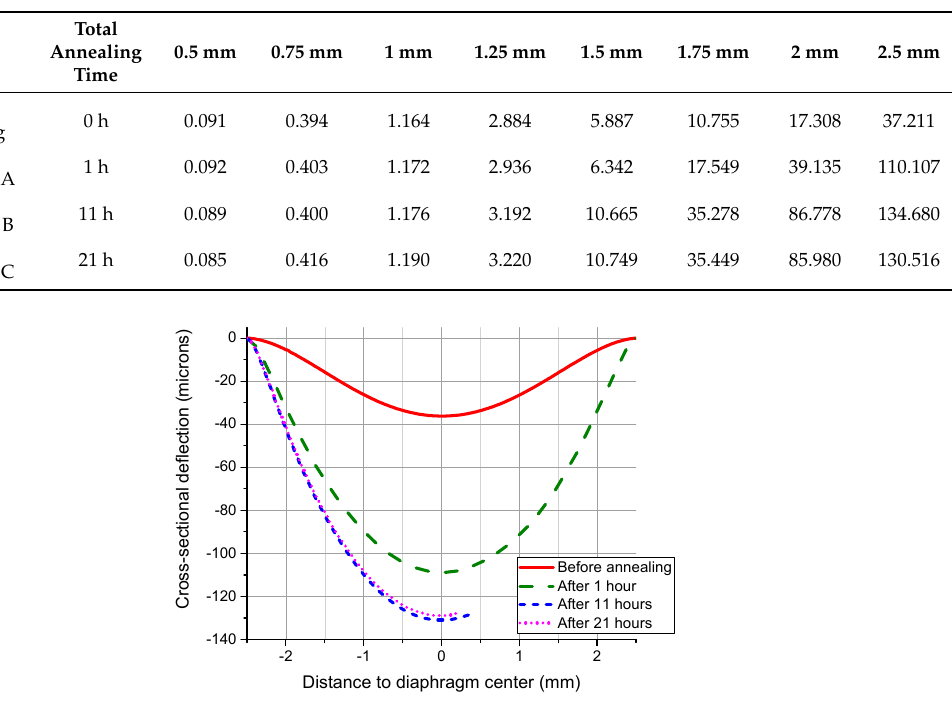
Table 5. The averaged maximum deflections (µm) with respect to the diaphragm radius at 900 °C.